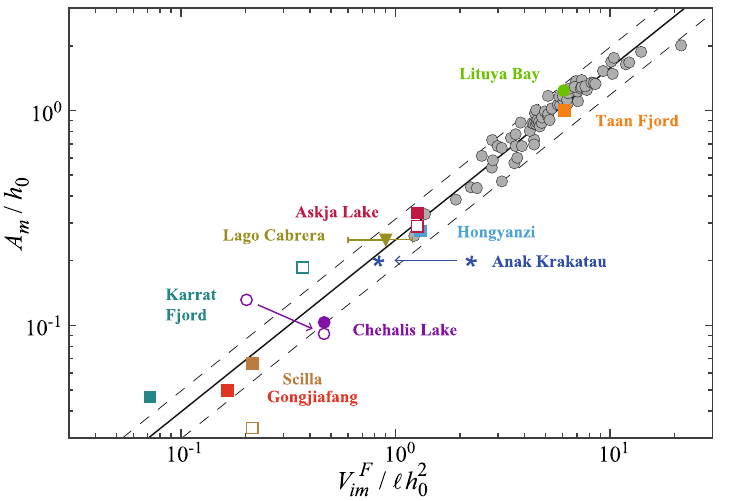
Figure 3. Rescaled maximal amplitude of the wave generated near-shore, A m / h 0 , as a function of the rescaled volume of the final immersed deposit V F im /ℓ h 2 0 for our experimental data (gray symbols) and data from the literature corresponding to the geophysical events reported in Table 1 (color symbols). The solid line corresponds to the scaling law (1) and the dashed lines indicate a deviation of